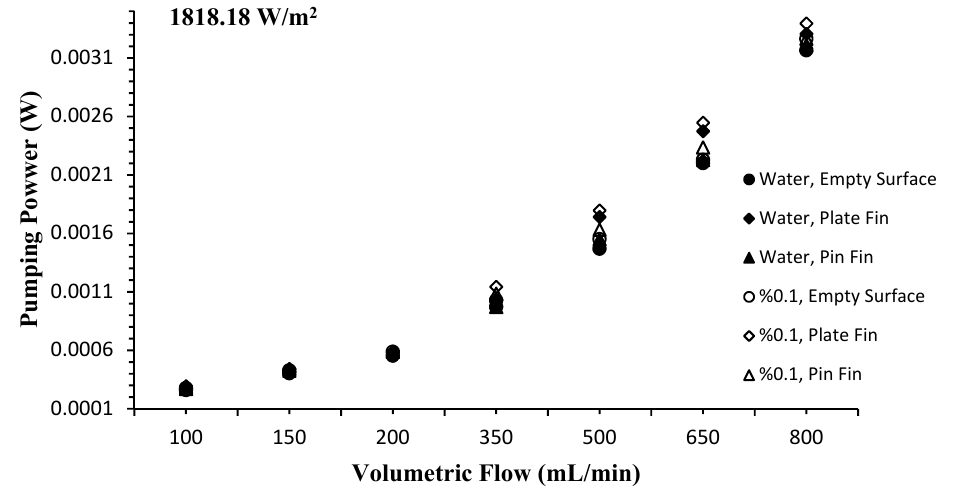
Figure 11. Pumping power versus the volumetric flow rate at different surface type heat sinks.